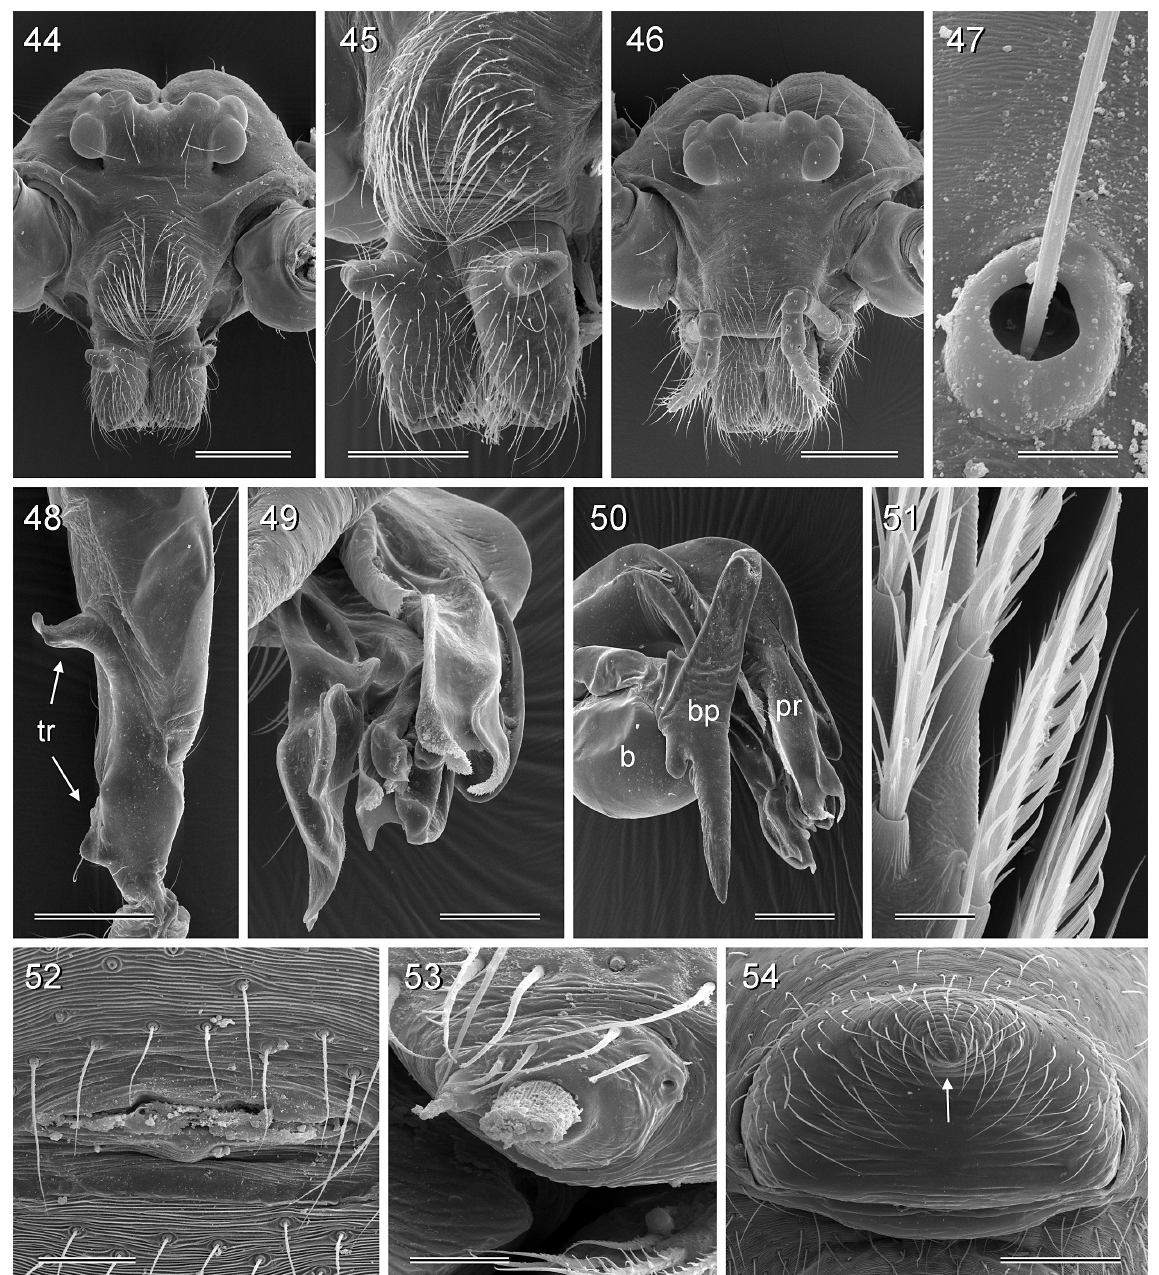
Figs 44–54. Savarna kraburiensis Wongprom & Wiwatwitaya, 2015. 44 . Male prosoma, frontal view. 45 . Male clypeus and chelicerae, oblique frontal view. 46 . Female prosoma, frontal view. 47 . Trichobothrium on female palpal tibia. 48 . Right male palpal trochanter (tr) and femur, prolateral view. 49 . Right procursus, prolatero-distal view. 50 . Right procursus (pr) and genital bulb (b), prolatero- distal view (bp = bulbal processes). 51 . Comb-hair on female left tarsus 4, prolateral view. 52 . Male gonopore. 53 . Female ALS. 54 . Epigynum, ventral view (arrow points at median process). Scale bars: 47, 51 = 10 µm; 53 = 20 µm; 52 = 60 µm; 49 = 100 µm; 45, 48, 50, 54 = 200 µm; 44, 46 = 300